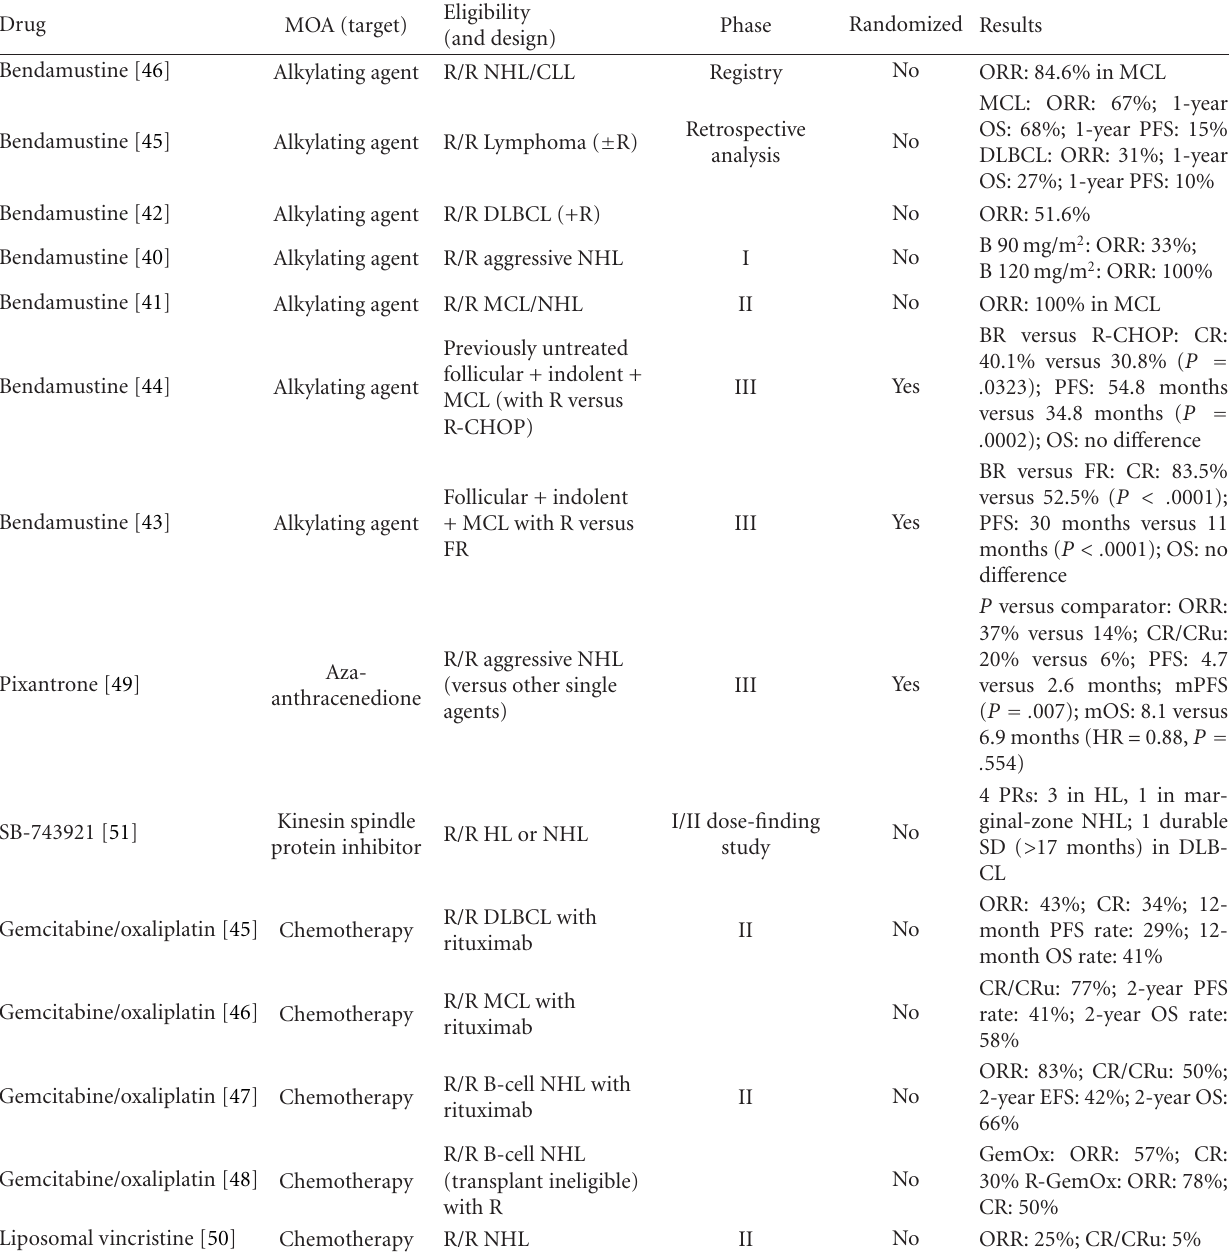
Table 1: Cytotoxic therapies in clinical development for the treatment of aggressive NHL. [B: bendamustine; CLL: chronic lymphocytic leukemia; CR: complete response; CRu: unconfirmed CR; DLBCL: di ff use large B-cell lymphoma; EFS: event-free survival; F: fludarabine; HL: Hodgkin lymphoma; MCL: mantle cell lymphoma; MOA: mechanism of action; mOS: median overall survival; mPFS: median progression-free survival; NHL: non-Hodgkin lymphoma; ORR: overall response rate; OS: overall survival; P: pixantrone; PFS: progression- free survival; PR: partial response; R: rituximab; R-CHOP: cyclophosphamide, doxorubicin, vincristine, prednisolone plus rituximab; R/R: relapsed or refractory; SD: stable